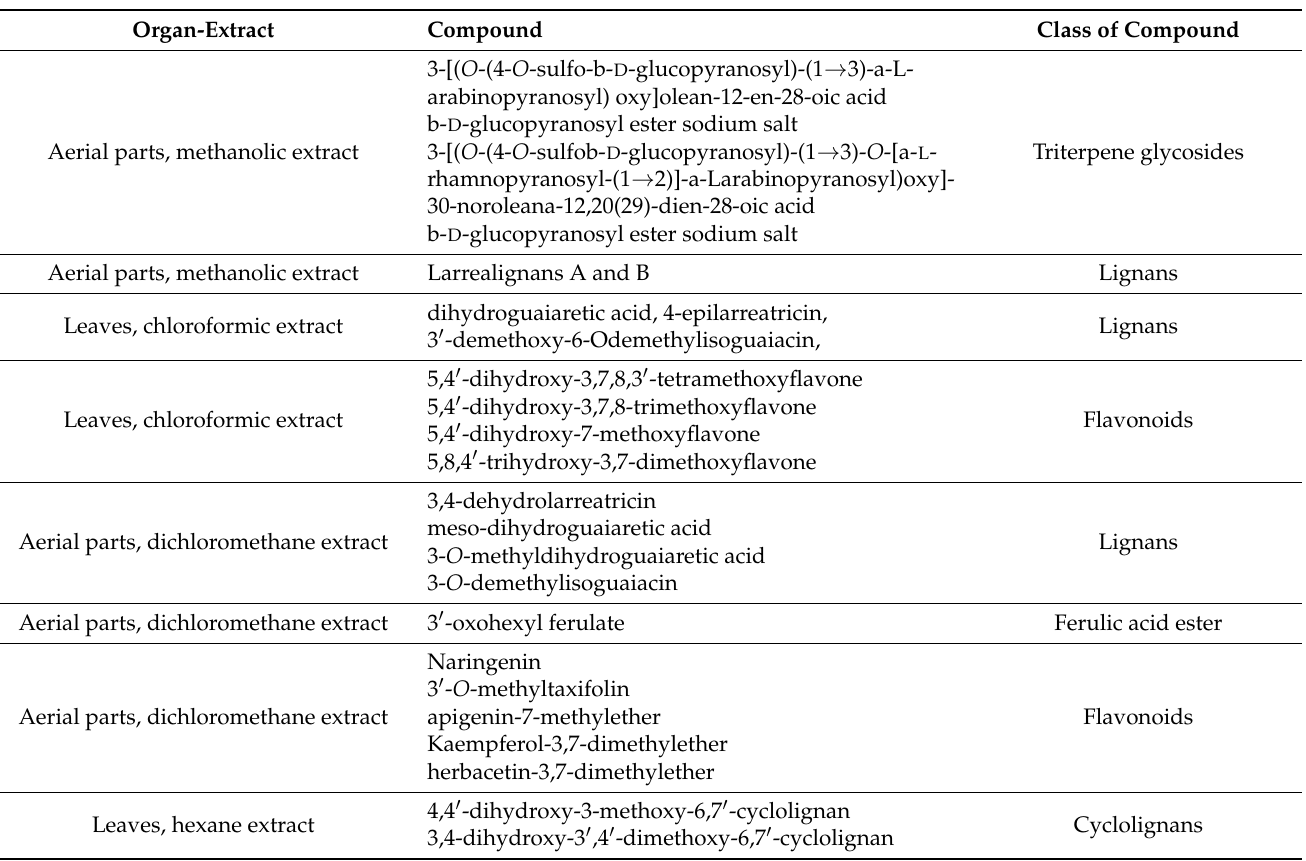
Table 3. Isolated compounds from Larrea tridentata